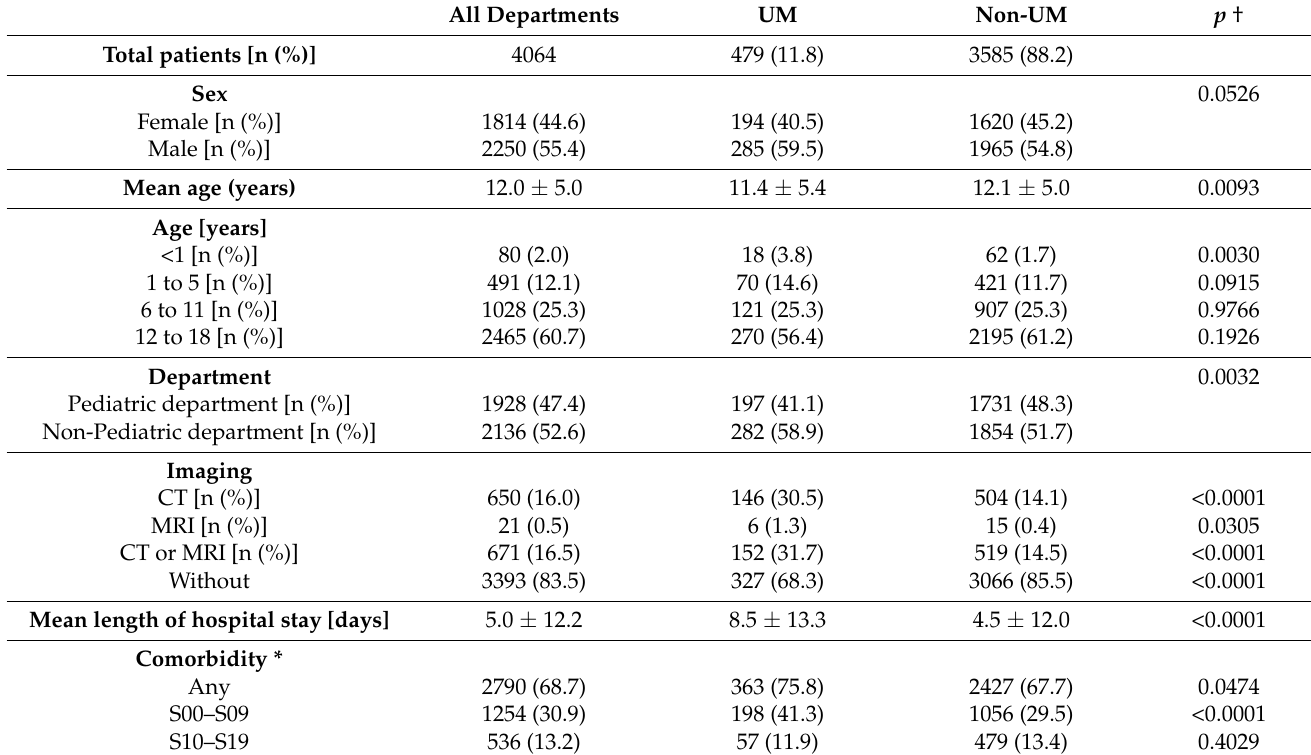
Table 4. Patient characteristics